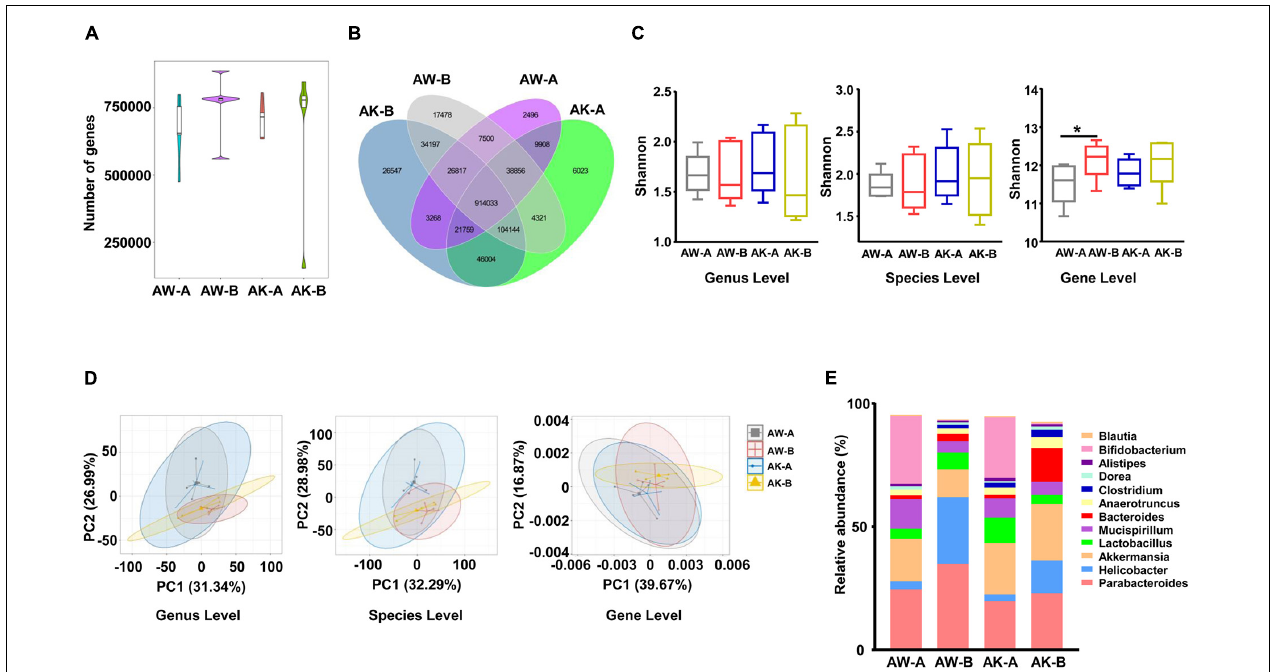
FIGURE 4 | Microbial composition changes among wild-type and adenosine monophosphate-activated protein kinase (AMPK)-knockout mice before and after angiotensin II treatment. (A) Gene count comparison among the four groups. (B) Venn comparison of the shared gene numbers and unique gene numbers among the four groups. (C) α -Diversity analysis (Shannon index) based on genus, species, and ortholog profile in the four groups. (D) Principal component analysis (PCA) of β -diversity analysis based on genus, species, and ortholog profile among the four groups. (E) The relative abundances of the top 12 highest abundant genera among the four groups. AW-A, wild-type mice (AMPK α 1 fl / fl /WT, already received tamoxifen injection), which did not receive angiotensin II treatment. AW-B, wild-type mice received angiotensin II stimulation for 7 days. AK-A, AMPK-knockout mice (AMPK α 1 fl / fl /Csf1r-MerCre, already received tamoxifen injection), which did not receive angiotensin II treatment. AK-B, AMPK-knockout mice received angiotensin II stimulation for 7 days. Gene level, i.e., ortholog level. * p < 0.05 by one-tailed Mann–Whitney U